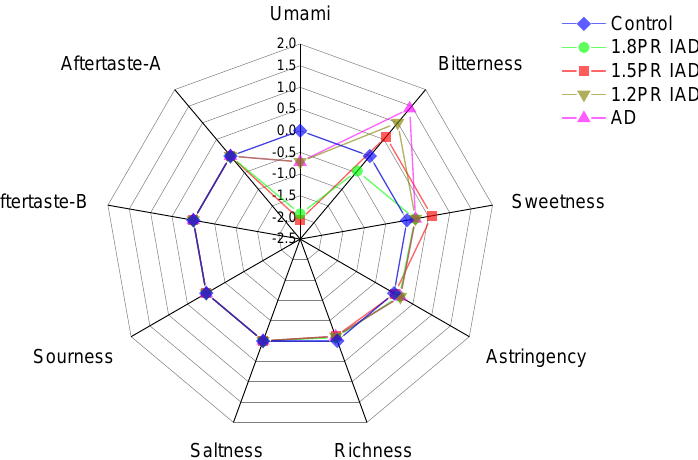
Figure 7. E-tongue evaluation of litchi dried by drying schemes with di ff erent pulse ratios. Note: AD is continuous air drying; the ratio 1.2 PR is an on 20 min and o ff 5 min pulse of intermittent air drying, the pulse ratio 1.5 PR is an on 20 min and o ff 10 min ratio of intermittent air dying, PR 1.8 is on 20 min and o ff 15 min; PR = [(on-drying time + o ff -drying time) / drying time] in one cycle.